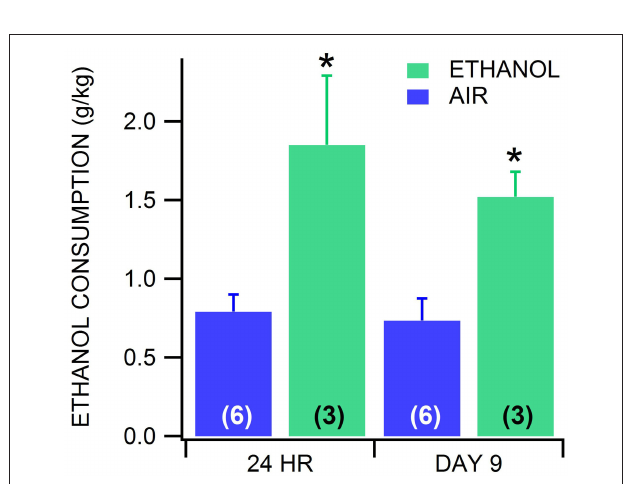
FIGURE 4 | Drink-in-the-dark model of alcohol dependence. In CD-1 GAD-67 GFP mice exposed to three continuous weeks of CIE vapor ( n = 3) or air ( n = 6), ethanol consumption in the DID test was significantly increased in mice receiving ethanol vapors vs. air-exposed mice. Dependent mice displayed increased drinking 24h after withdrawal from CIE vapor, and again on day 9 after last CIE vapor exposure. On day 9, mice were in 72h withdrawal following the last drinking test performed. Asterisks * mark statistical significance ( p < 0.05) between air and CIE vapor groups.